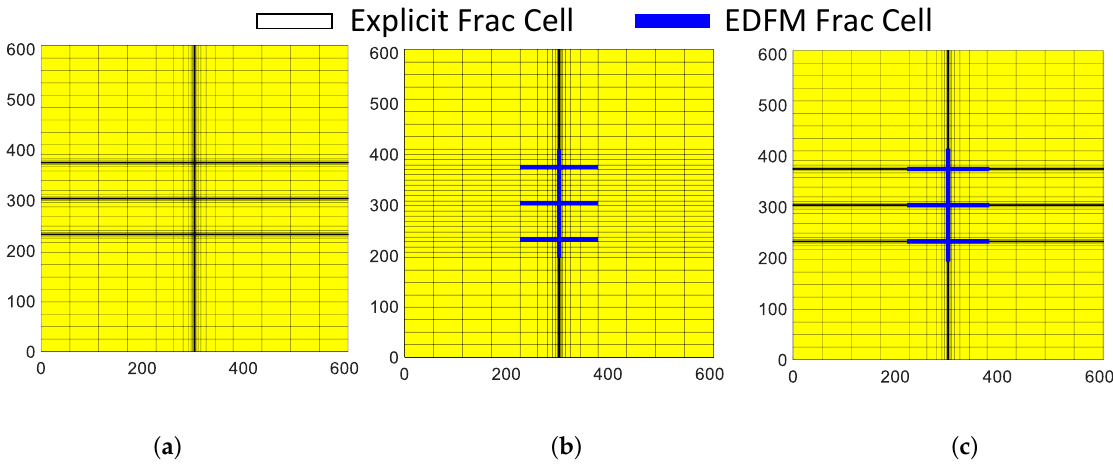
Figure 15. Grids for VE1C simulation: ( a ) LGR, ( b ) EDFM, ( c )